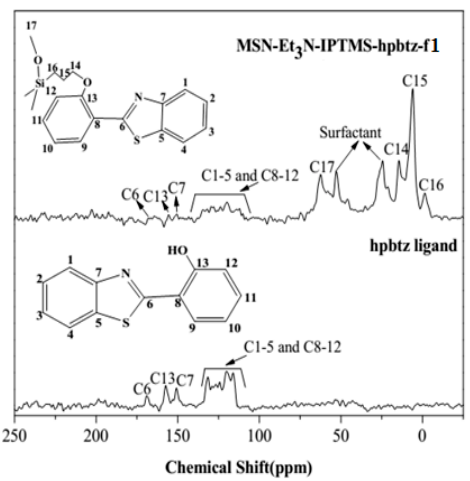
Figure 5. 13 C CP-MAS NMR spectra of hpbtz ligand and MSN-Et 3 N-IPTMS-hpbtz- f1 .